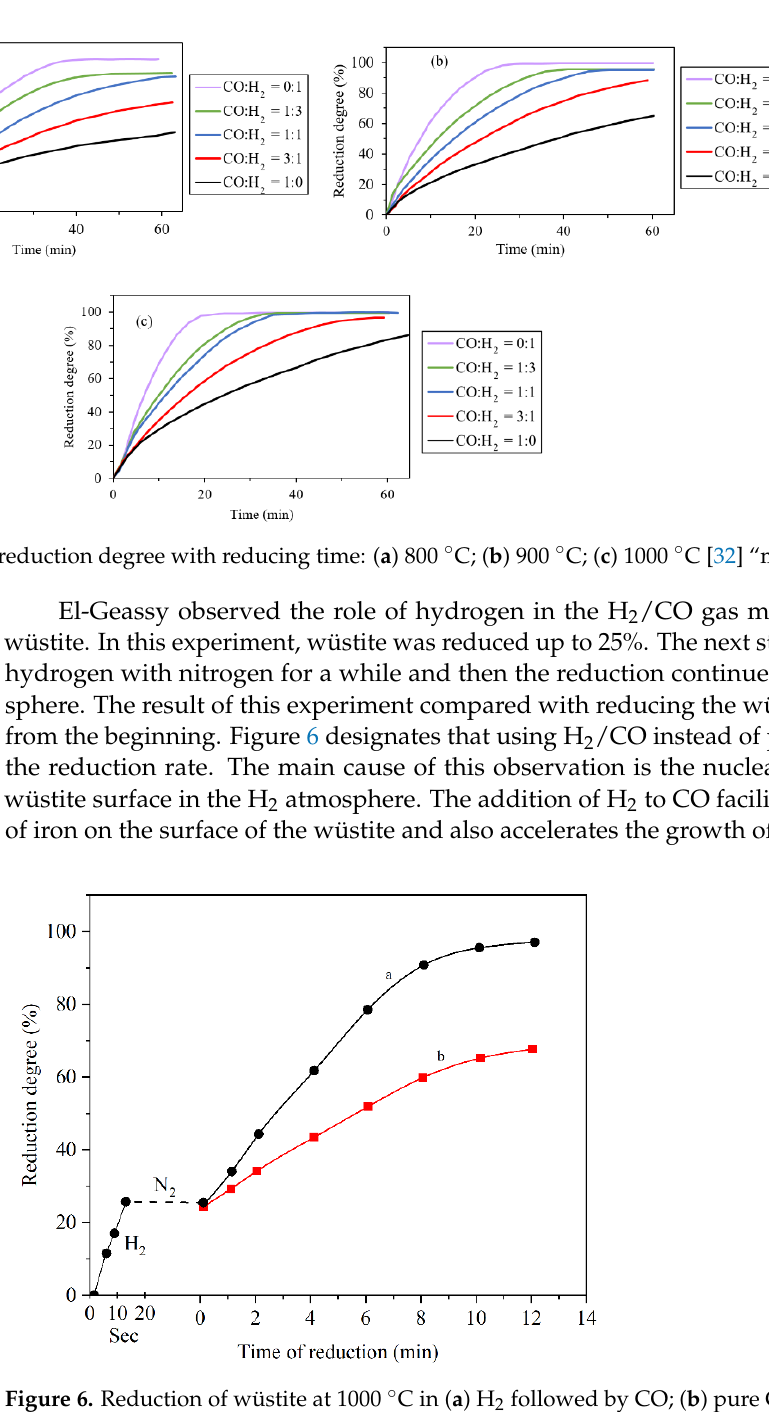
Figure 5. Change of reduction degree with reducing time: ( a ) 800 °C; ( b ) 900 °C; ( c ) 1000 °C [32] “modified”.